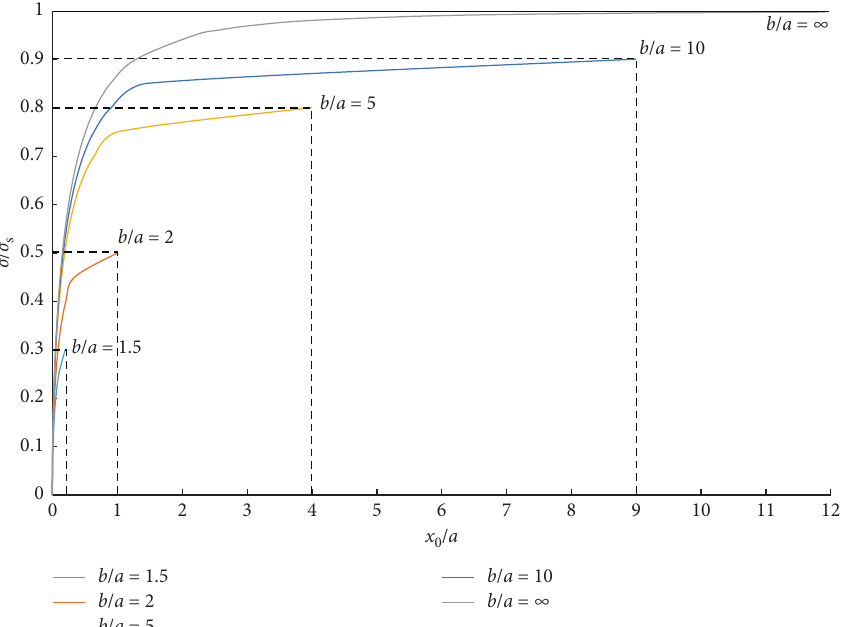
/ a ) with ( σ / σ s ) in different sized center-cracked 0